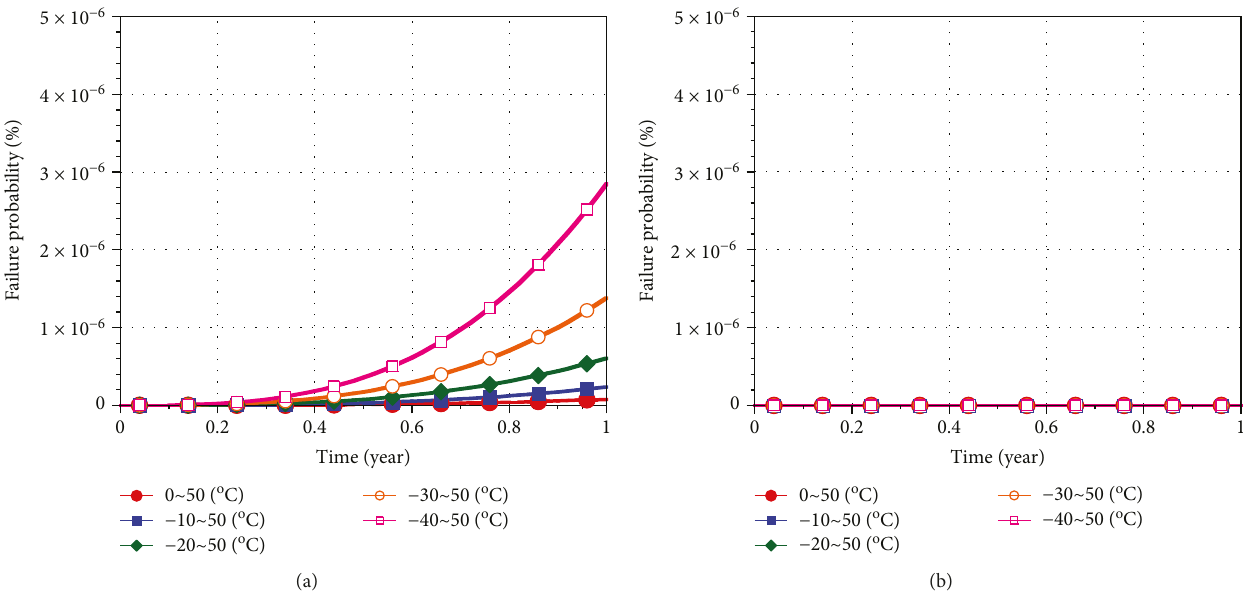
Figure 11: Time histories of the failure probabilities of U5 and U2 packages under lunar thermal environment ((a) U5 package and (b) U2 package).